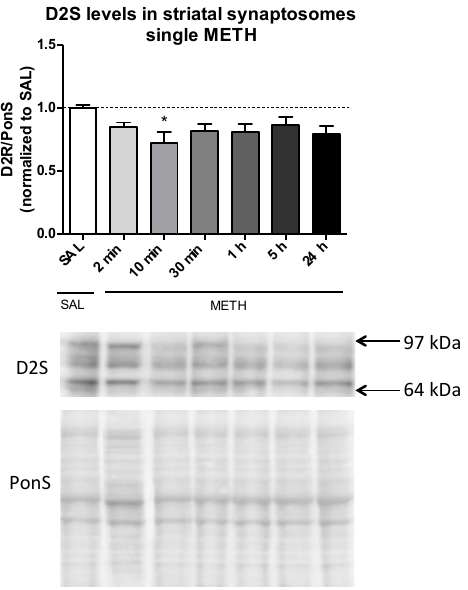
methamphetamine; PonS, Ponceau S; SAL,